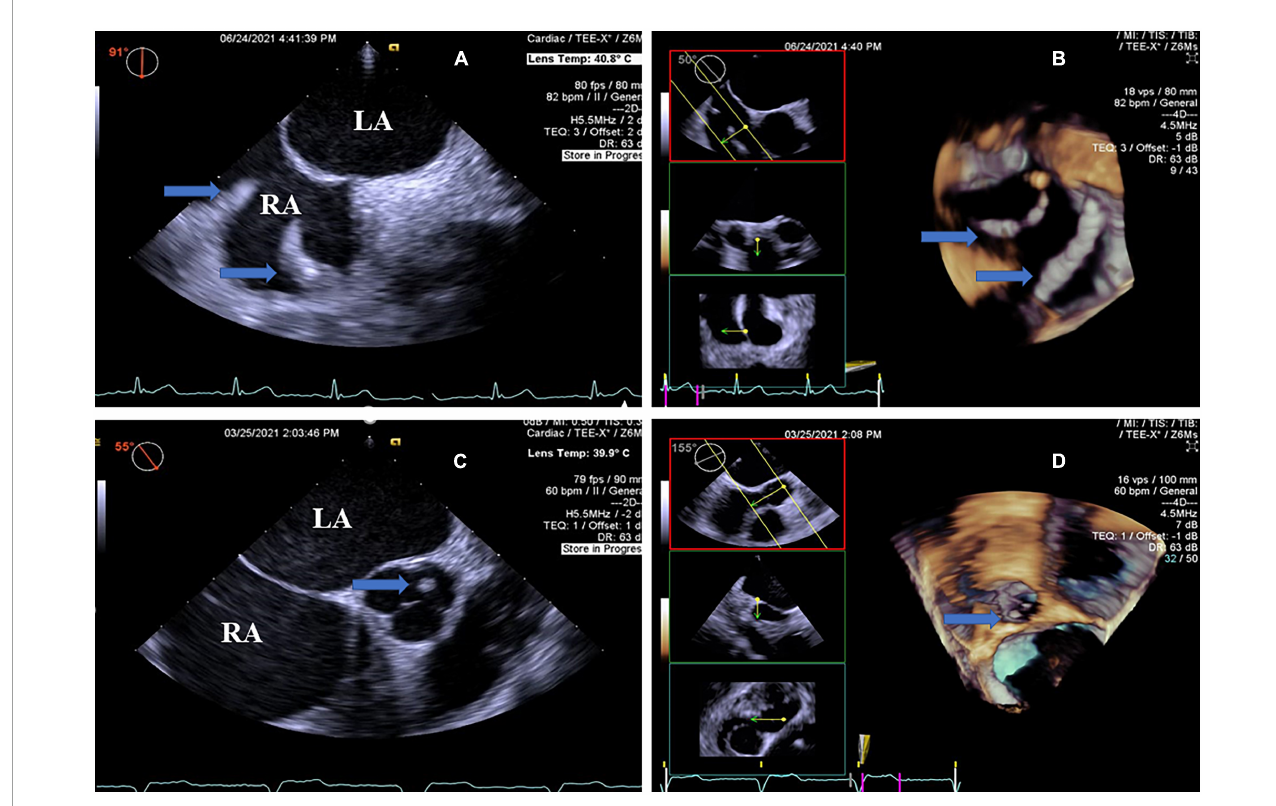
FIGURE4 Real-time four-dimensional-TEE evaluating the pacemaker lead-related thrombus and additional thrombus, as compared with 2D-TEE. (A) 2D-TEE showing local thickening of the two leads of the pacemaker in the right atrium (arrow) from the double atrial section view and the beaded thrombi (arrow). Note severe spontaneous echo contrast in the left atrium and right atrium. (B) RT4D-TEE visualizing the beaded thrombi fused to the pacemaker wire in the right atrium (arrow). (C) On the aortic root short axis view, 2D-TEE shows a round mass thrombus in the left aortic sinus attached to the aortic valve (arrow). Note severe spontaneous echo contrast throughout the left atrium and right atrium. (D) RT4D-TEE demonstrating an echogenic mass, looks like a round clot thrombus in the left aortic sinus attached to the aortic valve and more clearly than 2D-TEE (arrow) (Movie I–V). Movie I. At a 6-month follow-up, a 64-year-old man revealed a thin layer of thrombus covering the whole surface of the LACbes occluder by RT4D-TEE. Movie II. RT4D-TEE detected a mobile thrombus pedunculated on the face of the Watchman device. Thrombus adhered to the periphery of the occluder. Movie III. RT4D-TEE showed a lead-related floating thrombus in the right atrium. Movie Iv. RT4D-TEE evaluating the beaded thrombi fused to the pacemaker wires in the right atrium. Movie V. RT4D-TEE demonstrating the round mass thrombus in the left aortic sinus from the aortic root short axis